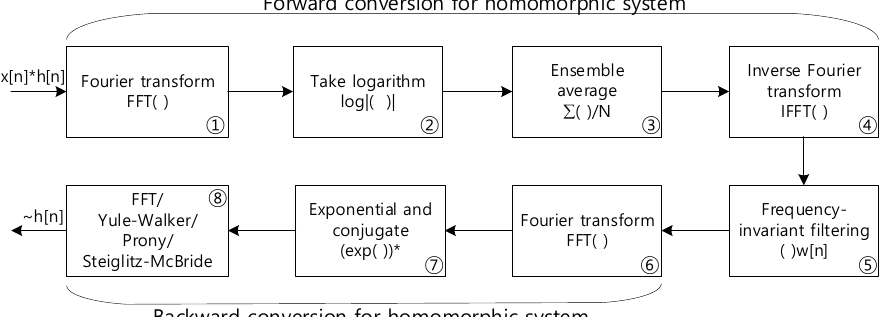
Figure 2. Computational procedure for the parametric and nonparametric homomorphic deconvolution. The * in stage ⑦ indicates the conjugate operation.